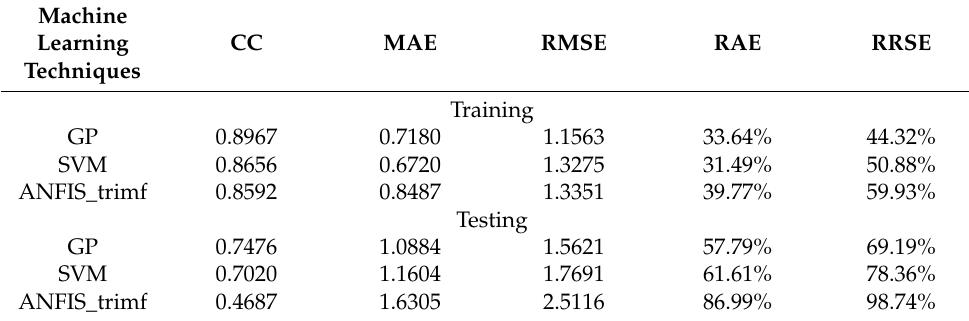
Table 9. Performances of SVM, GP, and ANFIS.